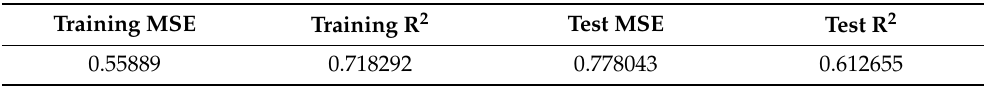
Table 1. Results of validation of a CO 2 emission model using MSE and R 2 for the gradient boosting machine learning technique for an LPG